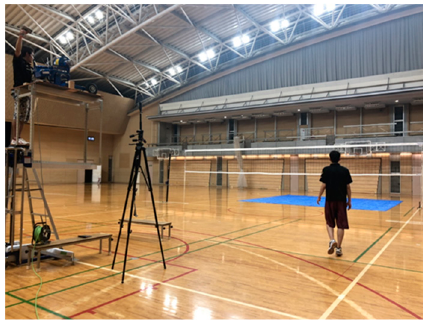
Figure 3. Outline of shotting experiment.